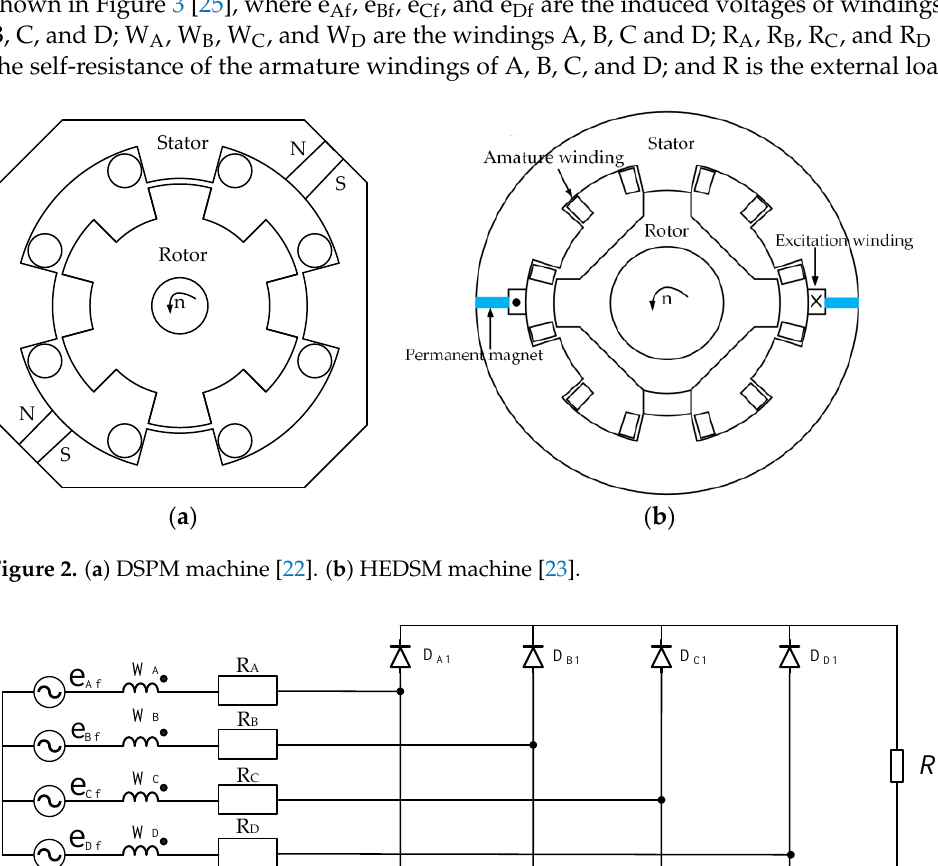
Figure 3. Full bridge rectifier circuit